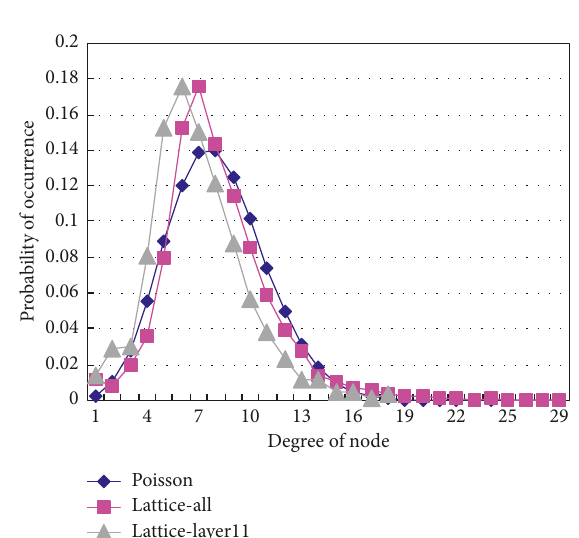
Figure 10: Poisson distribution curve fitting I.